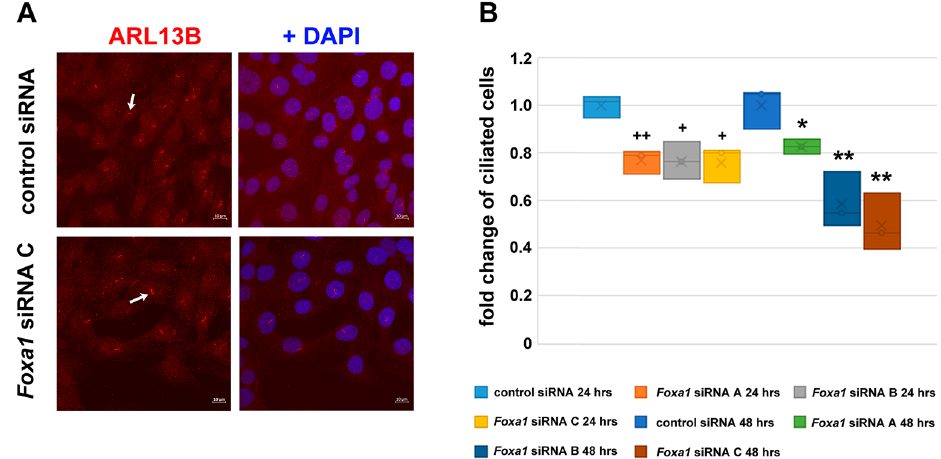
Figure 8. FOXA1 is mandatory for primary cilia formation. ( A ) Detection of primary cilia by immunodecoration of ARL13B (in red, arrows point to primary cilia). Merged images including nuclear counterstain with DAPI (in blue). Bars are of 10 µm. ( B ) siRNA-mediated depletion of Foxa1 led to a decrease in ARL13B-positive primary cilia. NIH3T3 cells were transfected either with the scrambled negative control siRNA, or one of either Foxa1 siRNA duplexes A, B, or C. 24 h post-transfection the medium was exchanged for serum starvation medium for cilia induction. Cells were fixed either after 24 h or 48 h in serum starvation medium and ARL13B decorated immunologically. ARL13B-positive primary cilia were manually counted. All experiments were performed in triplicates and n cells were counted: Foxa1 siRNA A (24 h) n = 1,599, FoxA1 siRNA B (24 h) n = 1,544, FoxA1 siRNA C (24 h) n = 1,564, control (24 h) n = 1,593, FoxA1 siRNA A (48 h) n = 1,593, FoxA1 siRNA B (48 h) n = 1,540, FoxA1 siRNA C (48 h) n = 1,590, control (48 h) n = 1,583. Student’s T-test two-tailed, homoscedastic, to control 24 h ( + , siRNA A p = 0.004569, siRNA B p = 0.011402, siRNA C p = 0.010086), or to control 48 h (*, siRNA A p = 0.031788, siRNA B p = 0.008451, siRNA C p = 0.004429). p < 0.05 *, p < 0.01